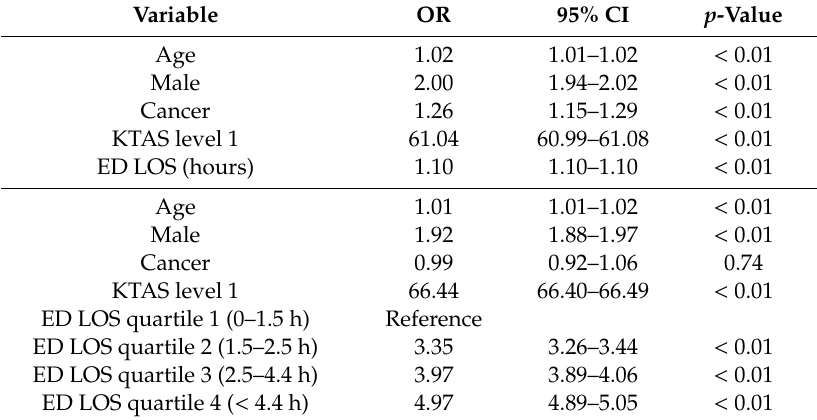
Table 3. Multivariate analysis of factors associated with in-hospital cardiac arrest (IHCA).